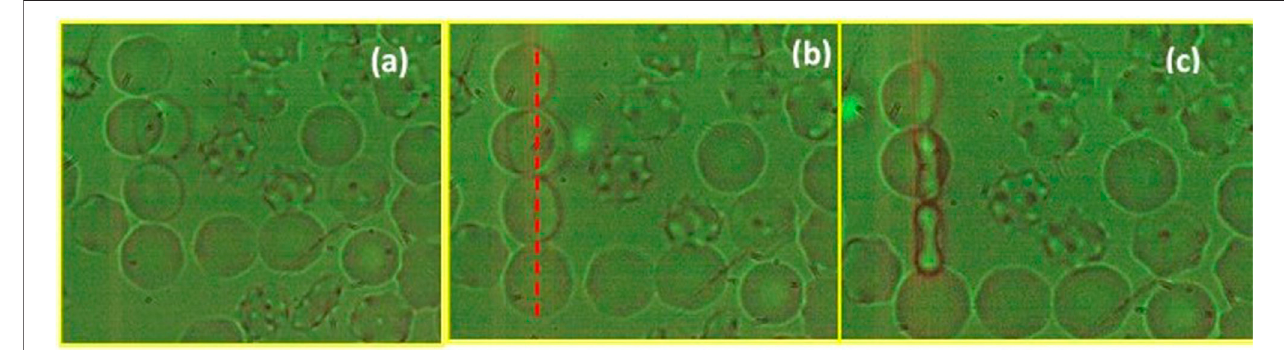
FIGURE3 |(A) Three red blood cells under a lineoptical tweezers. TheRBCsare trapped simultaneously, (B) are folded gradually and (C) orientits long axis in the direction of the electric fi eld of incident beam. Dotted red line is the direction of the line optical trap. Optical tweezers act as a tool for the evaluation of erythrocyte ’ s deformability which is an important biomarker for circulation ef fi